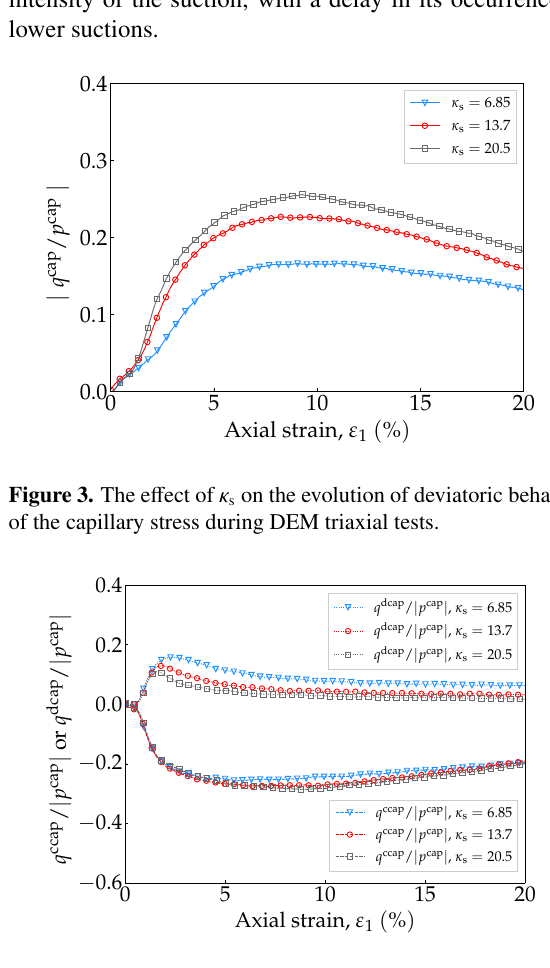
Figure 4. Decomposition of the deviatoric capillary stress for contact (ccap) and distant (dcap) interactions.